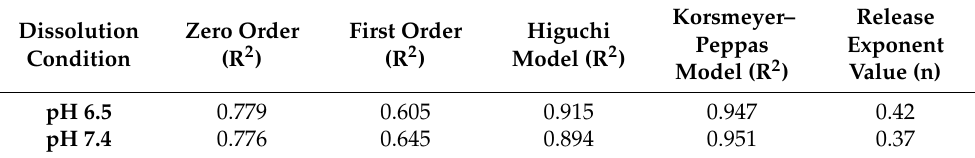
Table 3. Mathematical model for release kinetics dissolution data of